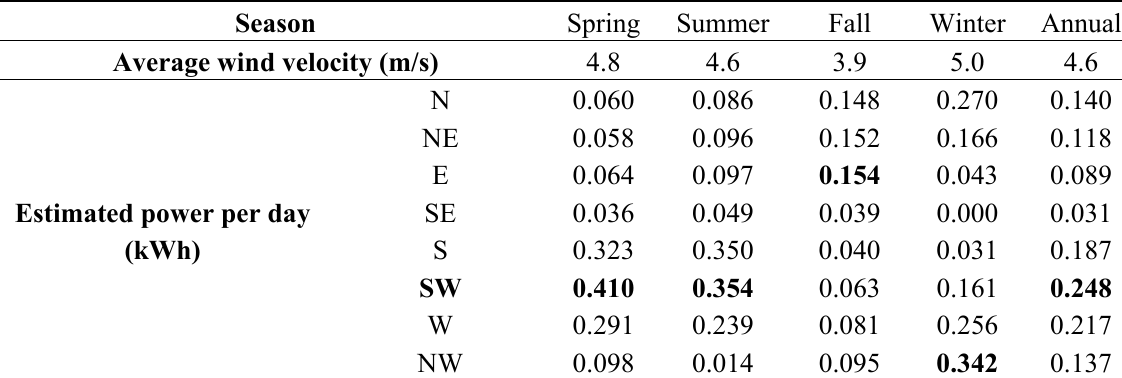
Table 6. Seasonal expected power for Busan,